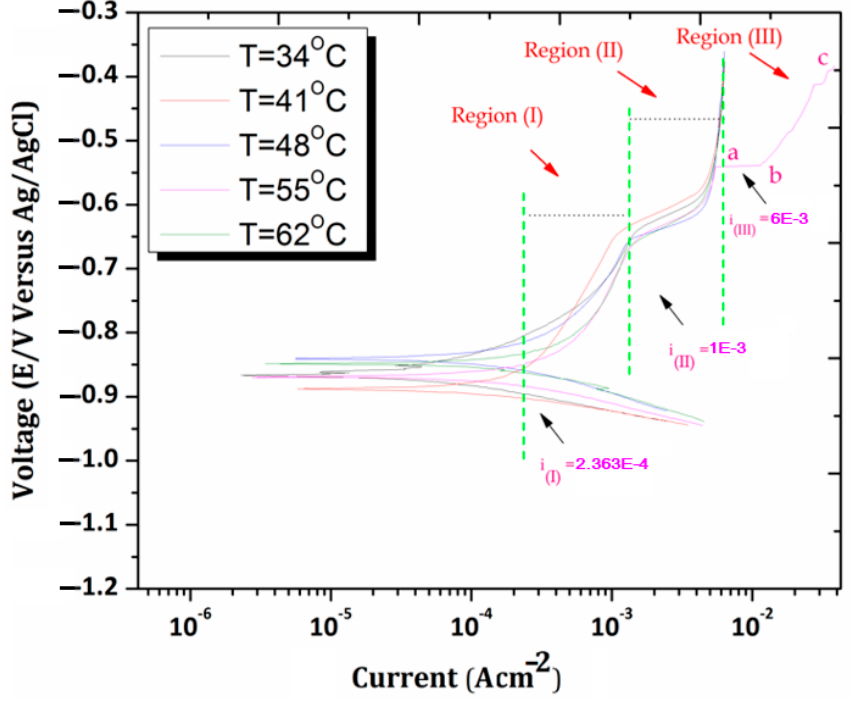
Figure 7. PDP plots of 17.5%B 4 C/Al-Mg-Si AMCs at various temperatures in 0.5 M NaCl environ-